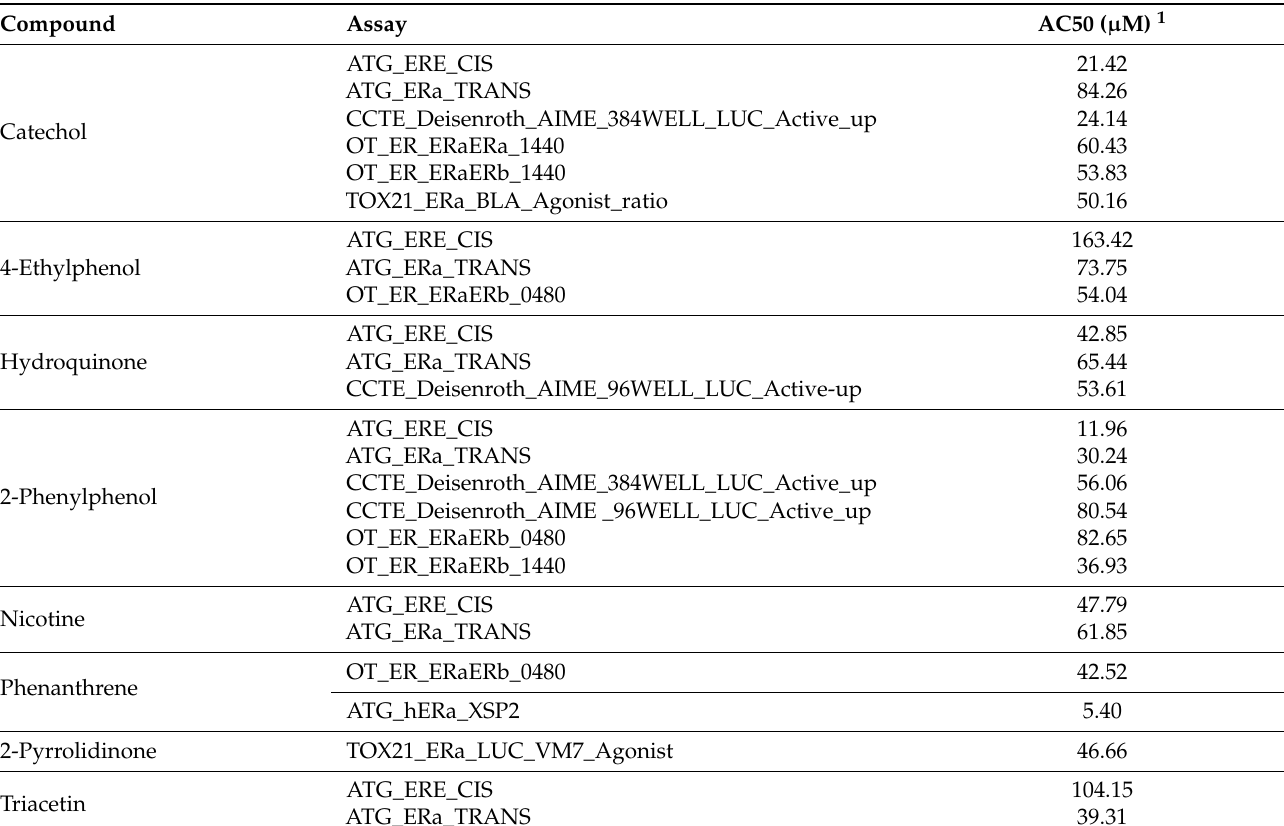
Table 3. Summary of the ER α agonist activities of putative estrogenic component compounds determined by EDSP21 and Tox21